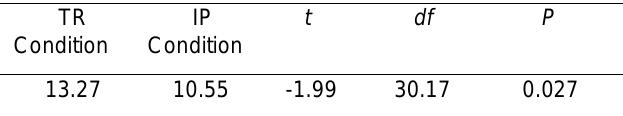
Table 3. Mean Number of Therapy Sessions Completed